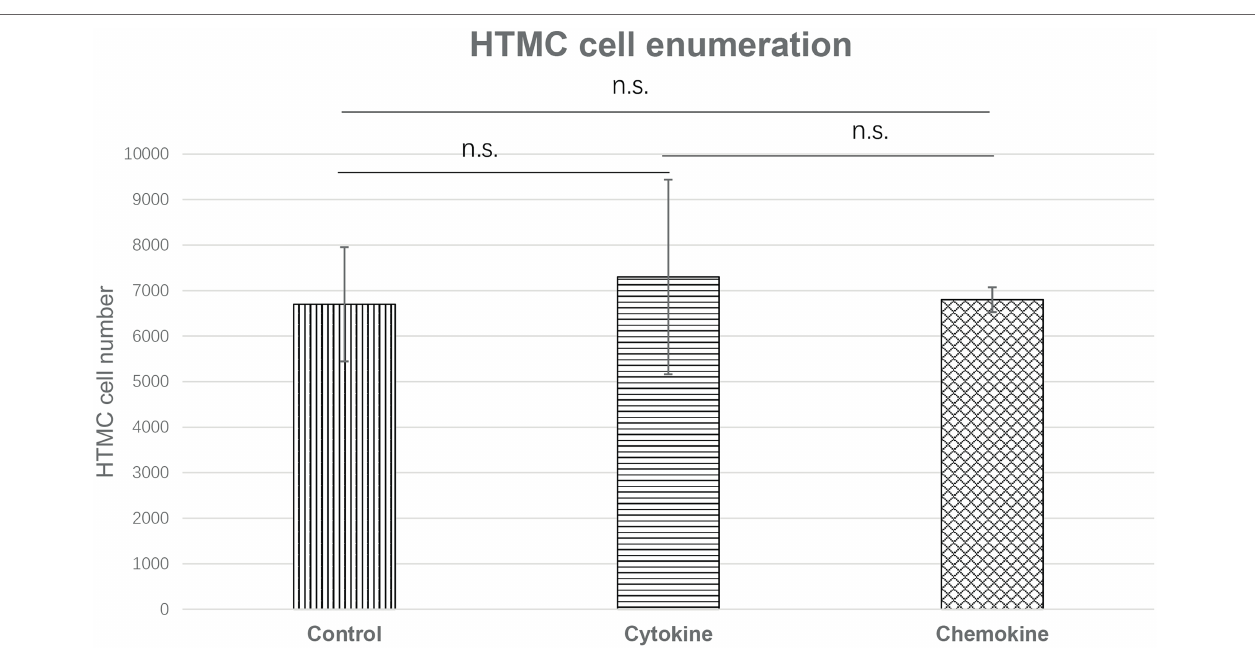
FIGURE 6 | Enumeration of HTMCs cultured with increased concentrations of cytokine (IL-6 30 ng/ml) or chemokines (CCL-2 40 ng/ml, CXCL-10 0.5 ng/ml, and CXCL-8 25 ng/ml) for 48 h. The number of HTMCs was 5 × 10 3 at the beginning of each respective culture. No significant changes in the number of HTMCs were detected among any